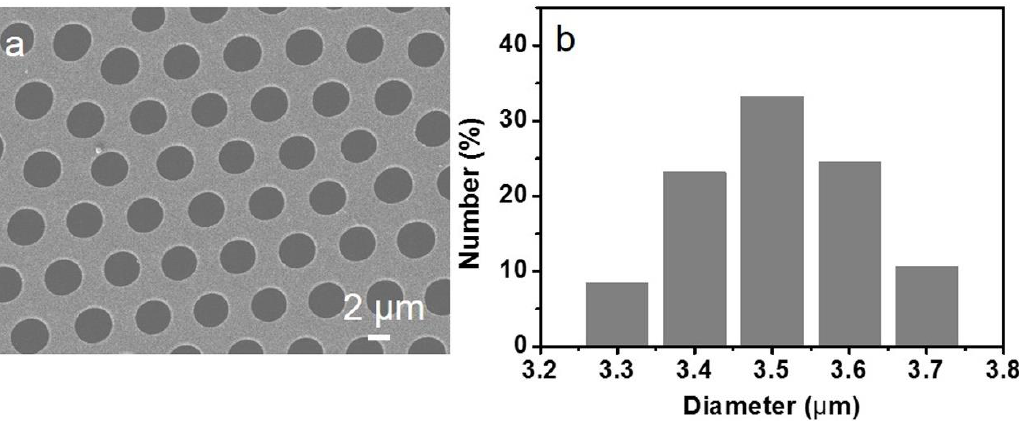
Figure 1. SEM images viewed from the ( a ) top surface of the porous film, and ( b ) histogram referring to the size distribution of cavities.